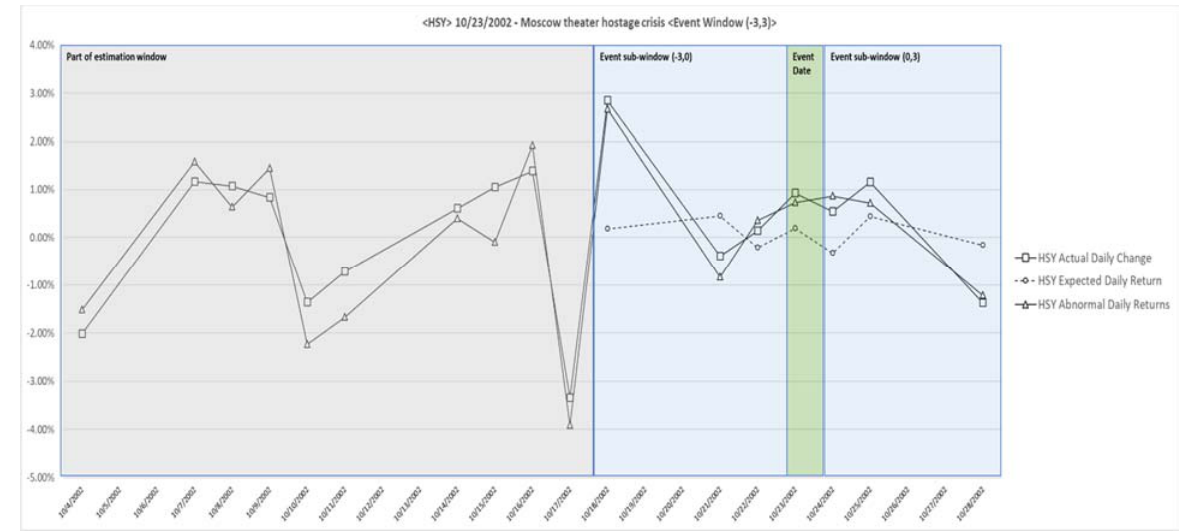
Figure 3. HSY’s daily abnormal returns to the Moscow theater hostage crisis: Event window ( − 3,3). For illustration purposes, we divide the event window ( − 3,3) into two event sub-windows (( − 3,0) and (0,3)), shown by the two light-blue background sections in Figure 3. The actual occurrence of the geopolitical event (the Moscow theater hostage crisis), also known as the “Event Date”, is captured between the two event sub-windows (and represented by the light-green background in Figure 3). After capturing the returns within the event window for this event we calculate the average abnormal returns for each day within the event window ( − 3,3).